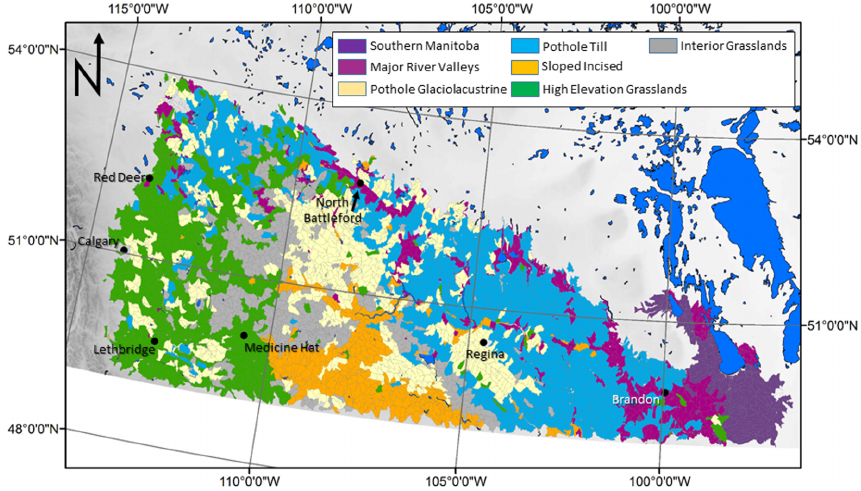
Figure 2. Basin classification map for the Prairie ecozone in western Canada. Colours represent the seven basin classes and excluded areas (lakes and urban areas) are shown in white. The focus of this paper is on the High Elevation Grasslands, shown in green. Climate data from the cities noted in this figure were used to drive the virtual model. Boundaries of the basins used in the classification are shown in